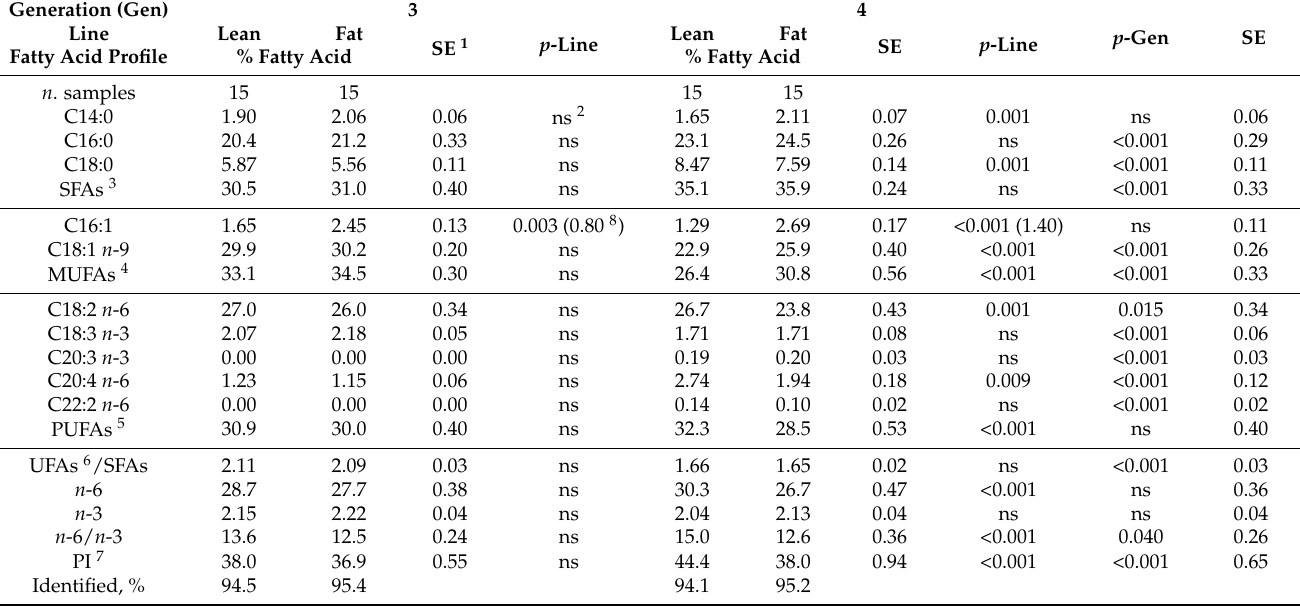
Table 3. Fatty acid profile (% of total FAMEs) of the hind legs of Lean and Fat rabbits in third and fourth generations of divergent selection for total body fat